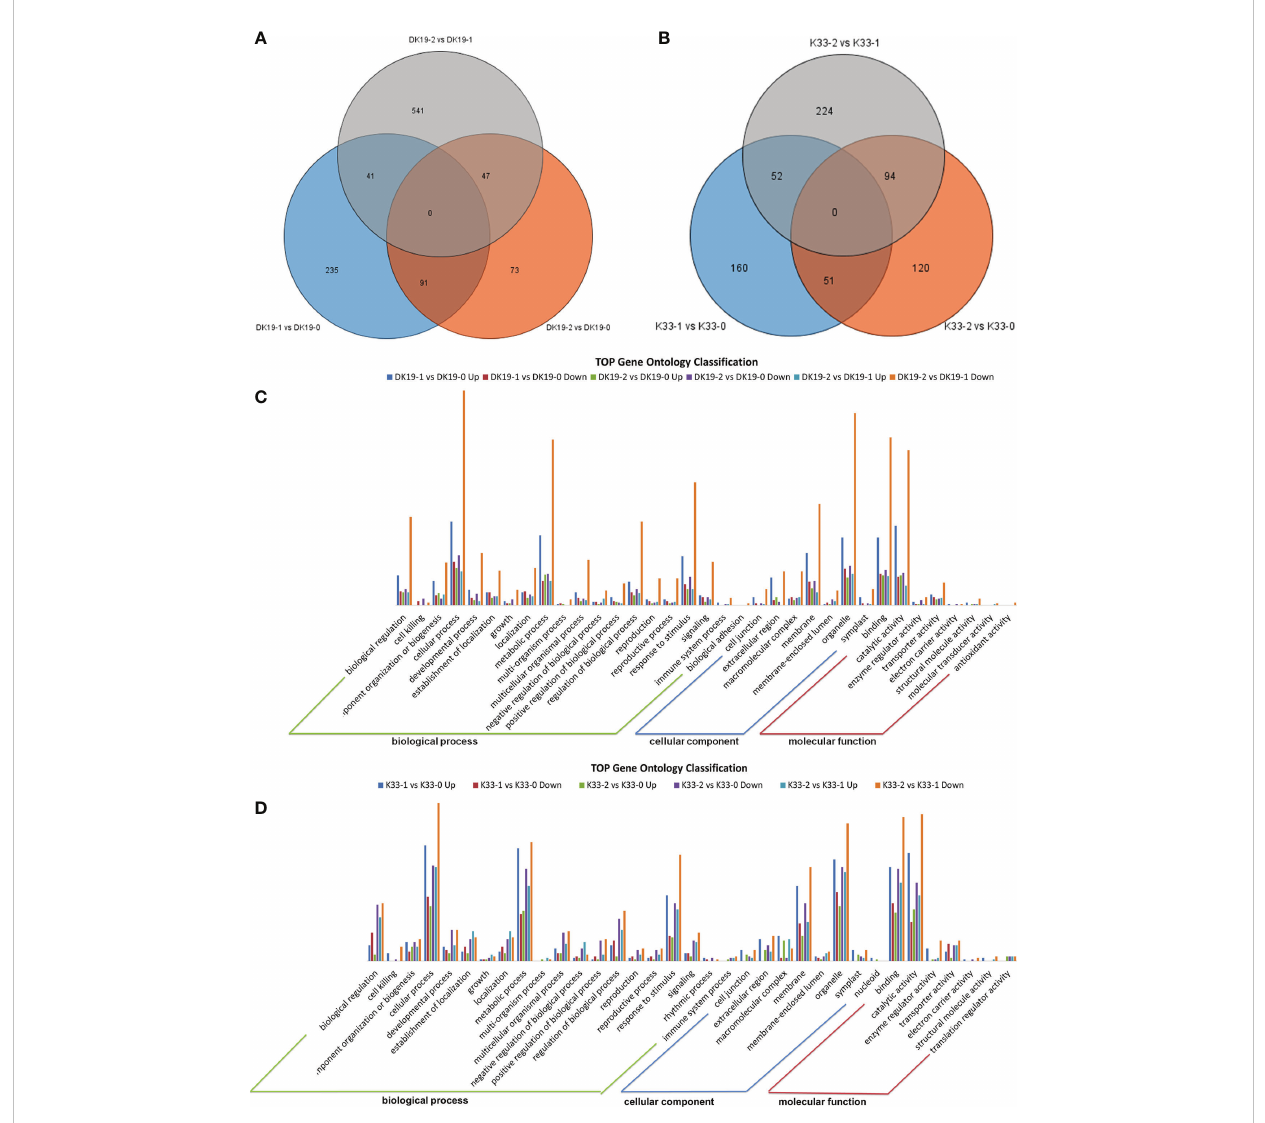
FIGURE 7 The quality and quantity of the RNA sequencing, generated using high-throughput deep sequencing technology; (A) Venn diagrams of differentially expressed genes (DEGs) among the three stages. DK19 and K33 represent two materials, DK9-0 and K33-0 are the control without Cd treatment, DK19-1 and K33-1 are the test results after 7 days of treatment, and DK19-2 and K33-2 are the test results after 14 days of treatment. The selected gene is average TPM> 0.5. (B) Relationship between samples in three biological replicates and summary of expressed genes in different treatments. (C, D) Venn diagrams of differentially expressed genes (DEGs) among the four stages. 0D represents the control without IAA treatment, 1D represents the sample after 1 day of treatment, 2D represents the sample after 2 days of treatment, and 3D represents the sample after 3 days of treatment. The selected gene is average TPM>